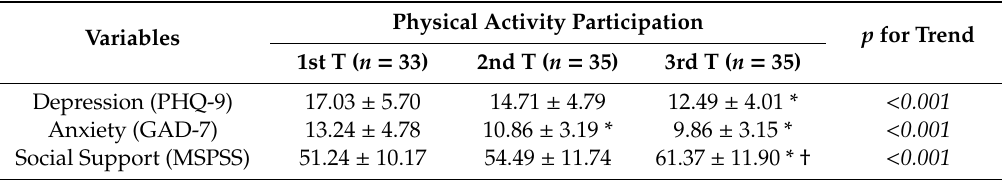
Table 2. Association between physical activity and mental health variables in participants with SCI. Variables